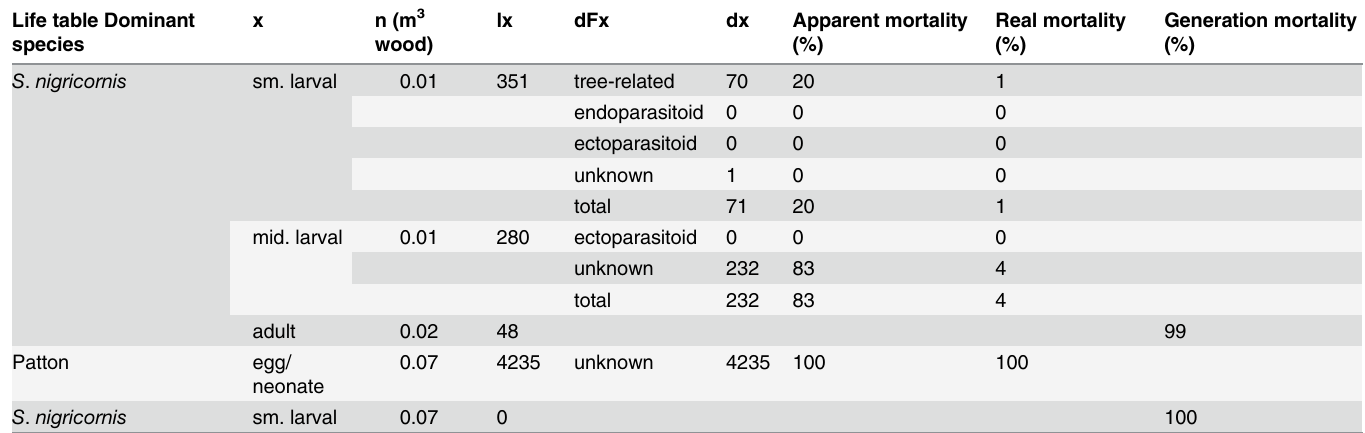
the curves existing between the first two life stages (Fig 1). Densities of surviving S . noctilio were not different between the experimentally-manipulated cohorts in the first two life stages, but they were significantly greater in the protected compared with the exposed cohort in the final two life stages (z = 2.49; df = 1,16; P = 0.012 and z = 3.64; df = 1,16; P < 0.001 for mid- sized larval and adult stages, respectively; Fig 2). The number of mid-sized larvae and adults were, on average, 2.5 and 16.5 times larger in the protected compared with the exposed cohort. At most sites, the shape of survivorship curves for natural cohorts (Fig 1b) was similar to that of the experimentally-protected cohort (Fig 1a); Thames was most similar to the experimen- tally-exposed cohort.